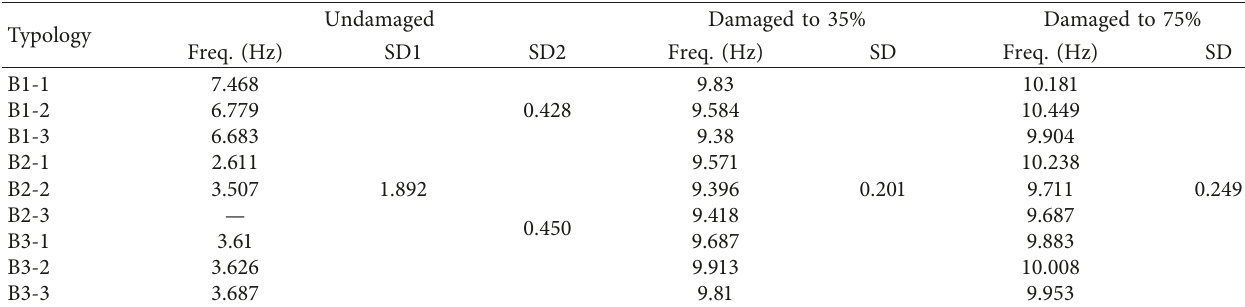
Table 5: Frequency values and standard deviation (SD) for the 1st bending modal